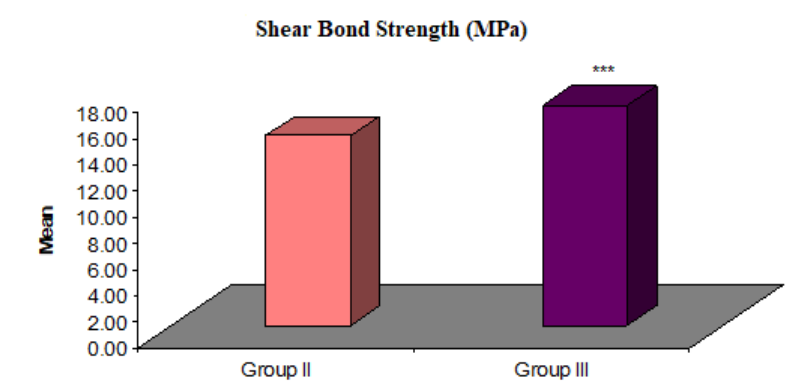
Fig. 8. Bar diagram depicting comparisons of difference in mean shear bond strength between two